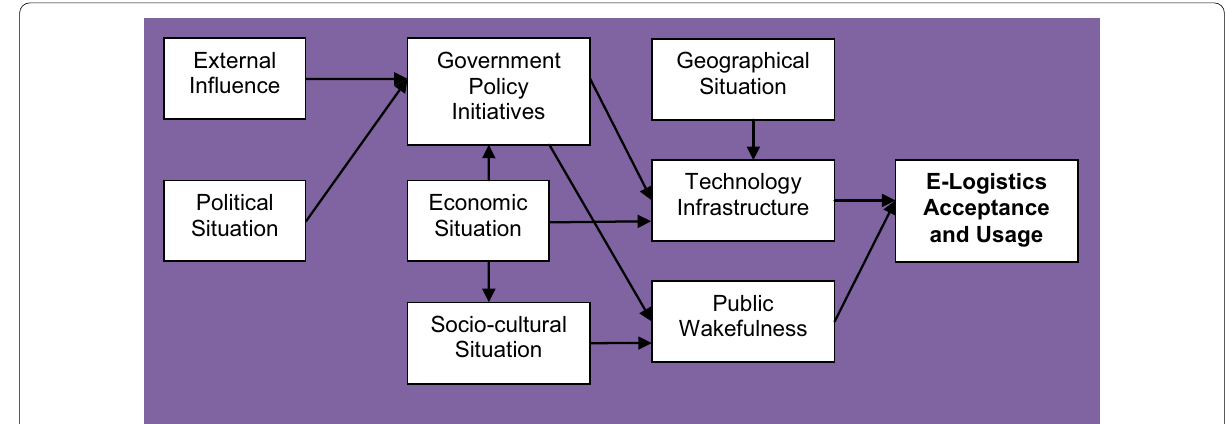
Fig. 2 Factors influencing the acceptance and patronage of e-commerce